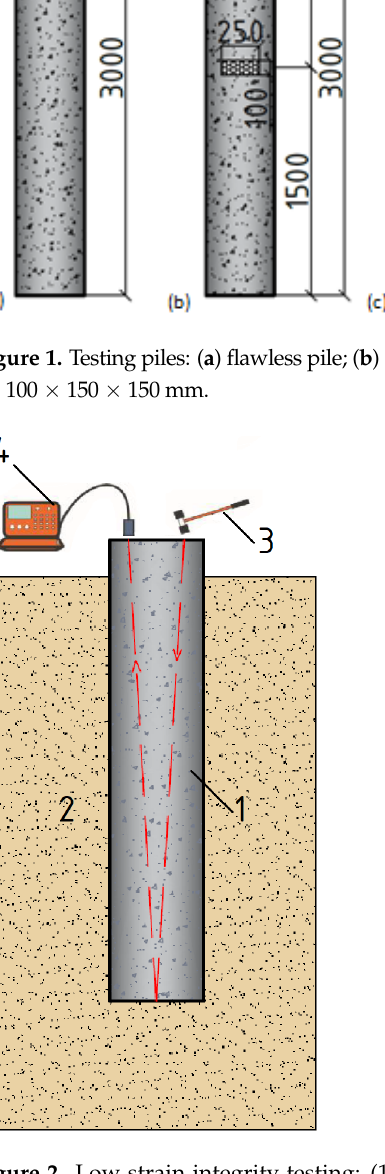
Figure 2. Low strain integrity testing: (1) cast-in-place pile; (2) soil mass; (3) handheld hammer; (4) equipment set; red dotted lines indicate wave propagation.